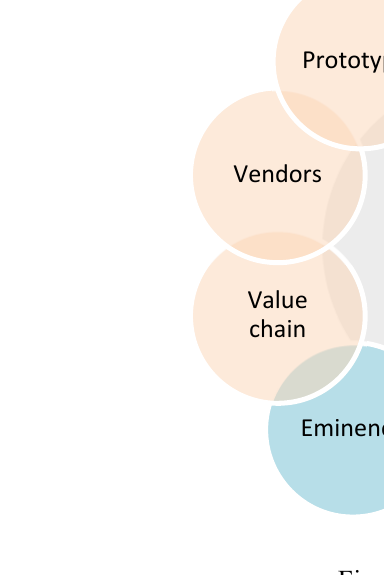
Figure 9. Digital reality